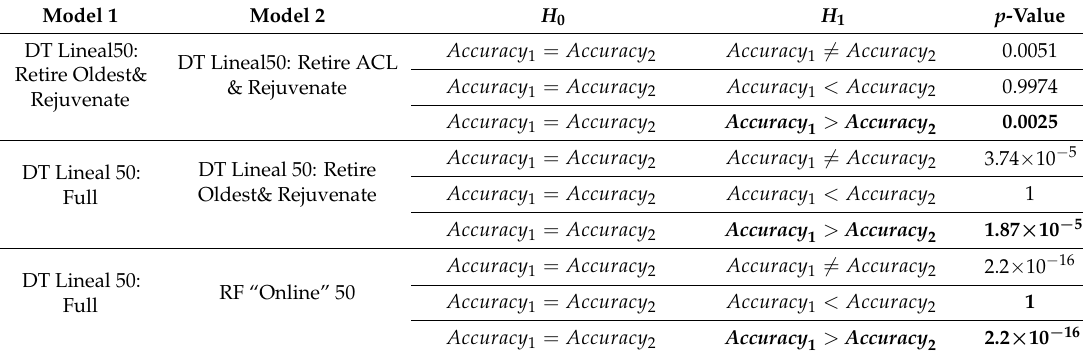
Table 10. One-Day ahead forecast results for the Diebold-Mariano